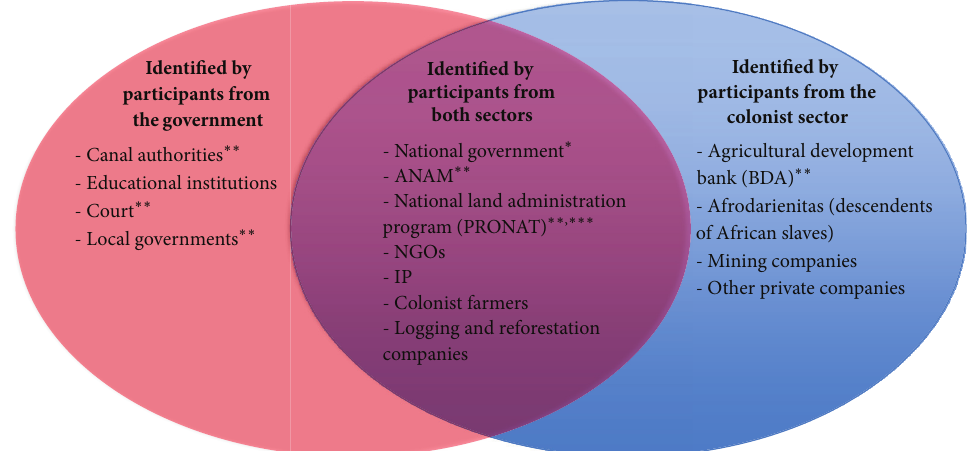
F 2: Different REDD+ stakeholders who were identi�ed during phase